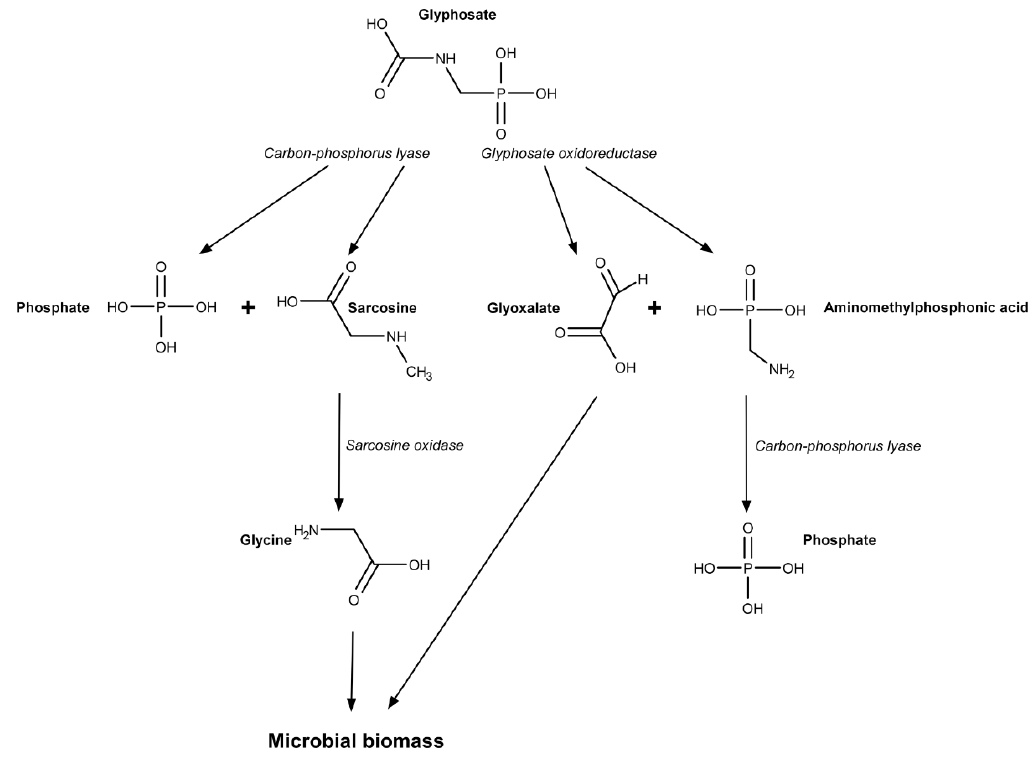
Figure 1: Metabolism of glyphosate in